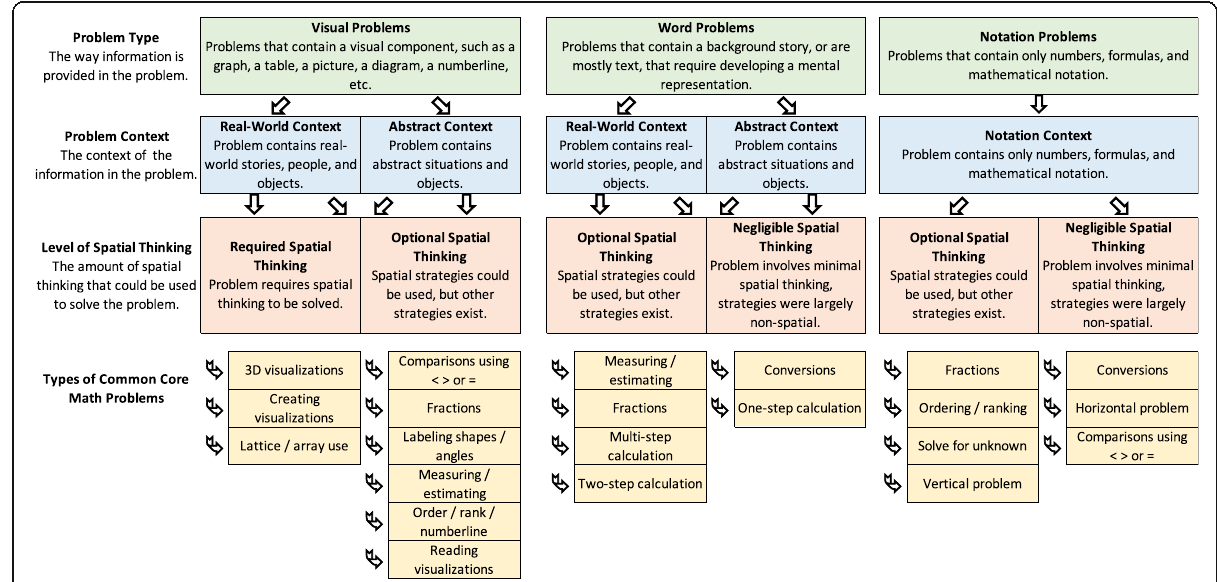
Fig. 1 Math categorization including definitions of problem type, problem context, and spatial thinking. Flow chart of how each problem type relates to problem contexts, then how problems contexts relate to spatial thinking, and then types of Common Core Math problems that fit within each